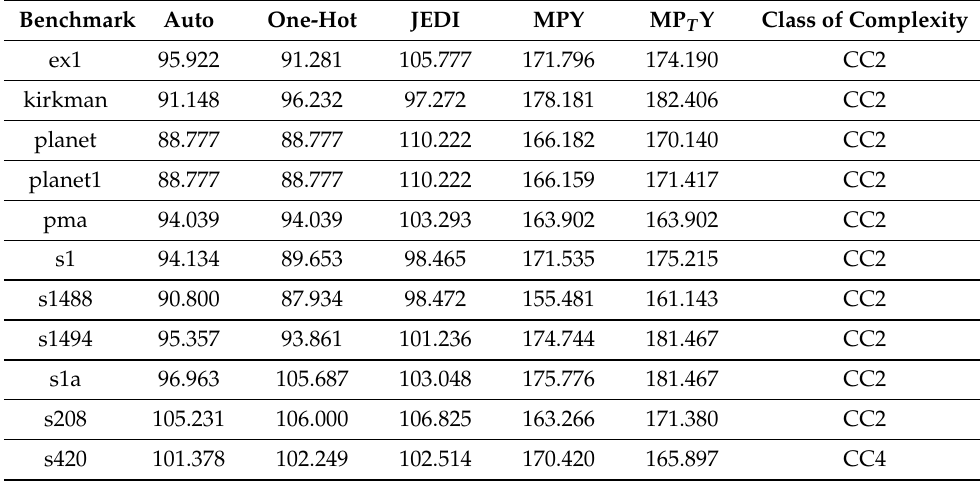
Table 16. Experimental results (the frequencies for classes CC2-CC4